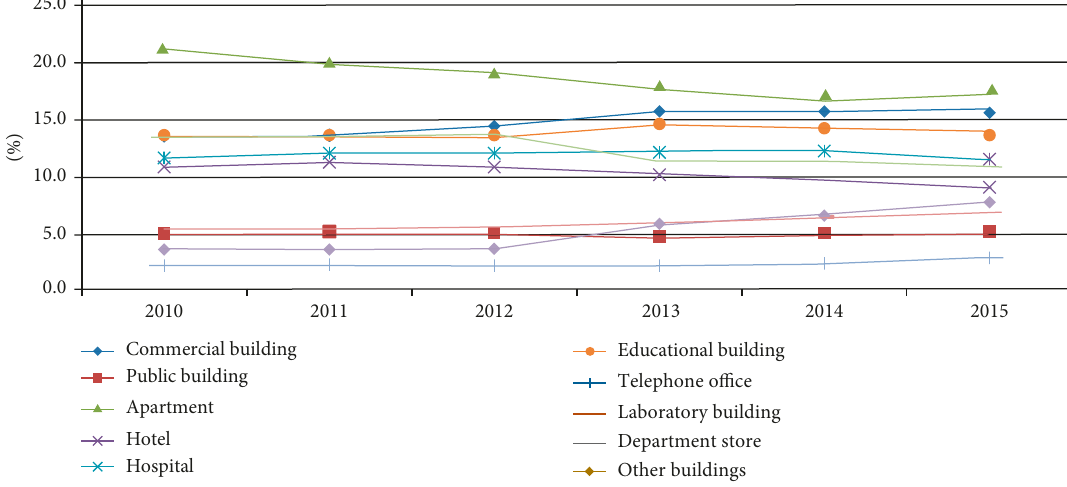
Figure 1: Energy use composition ratio by building sector in Korea